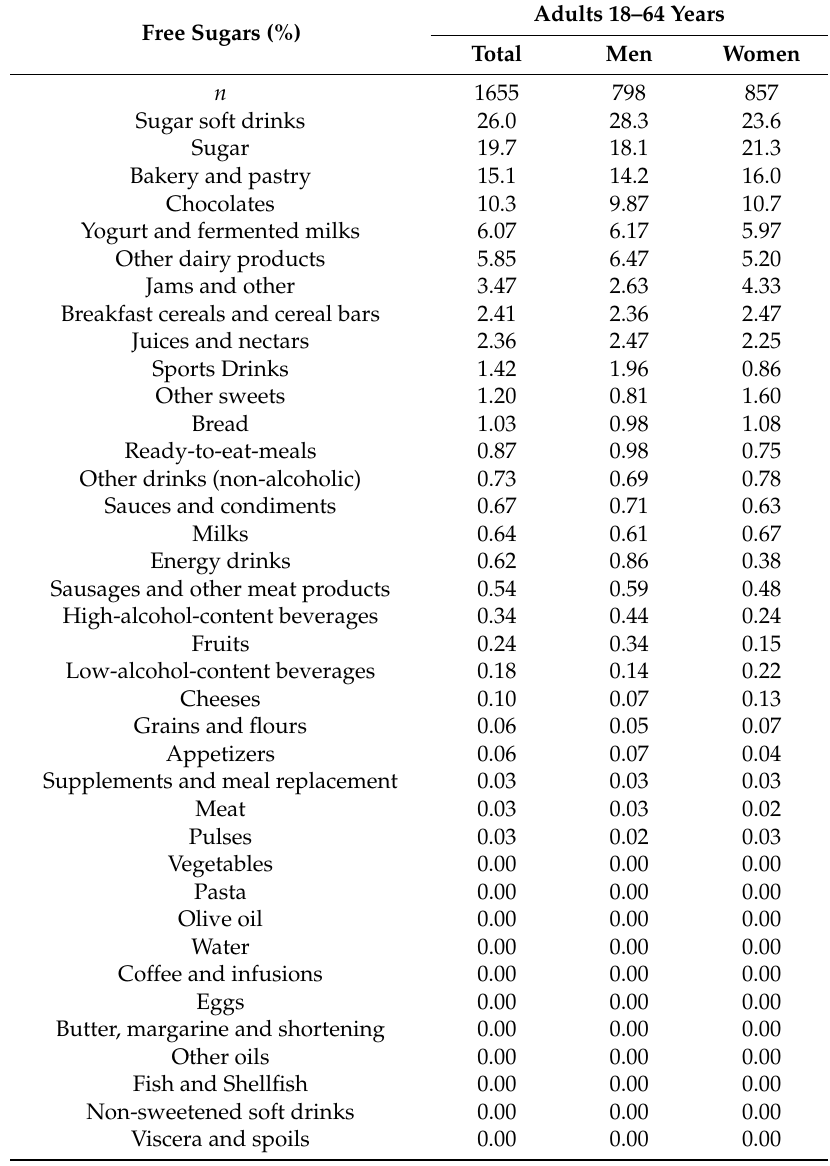
Table 13. Dietary sources of free sugars (%) from food and beverage subgroups in the ANIBES Study Spanish population aged 18–64 years: